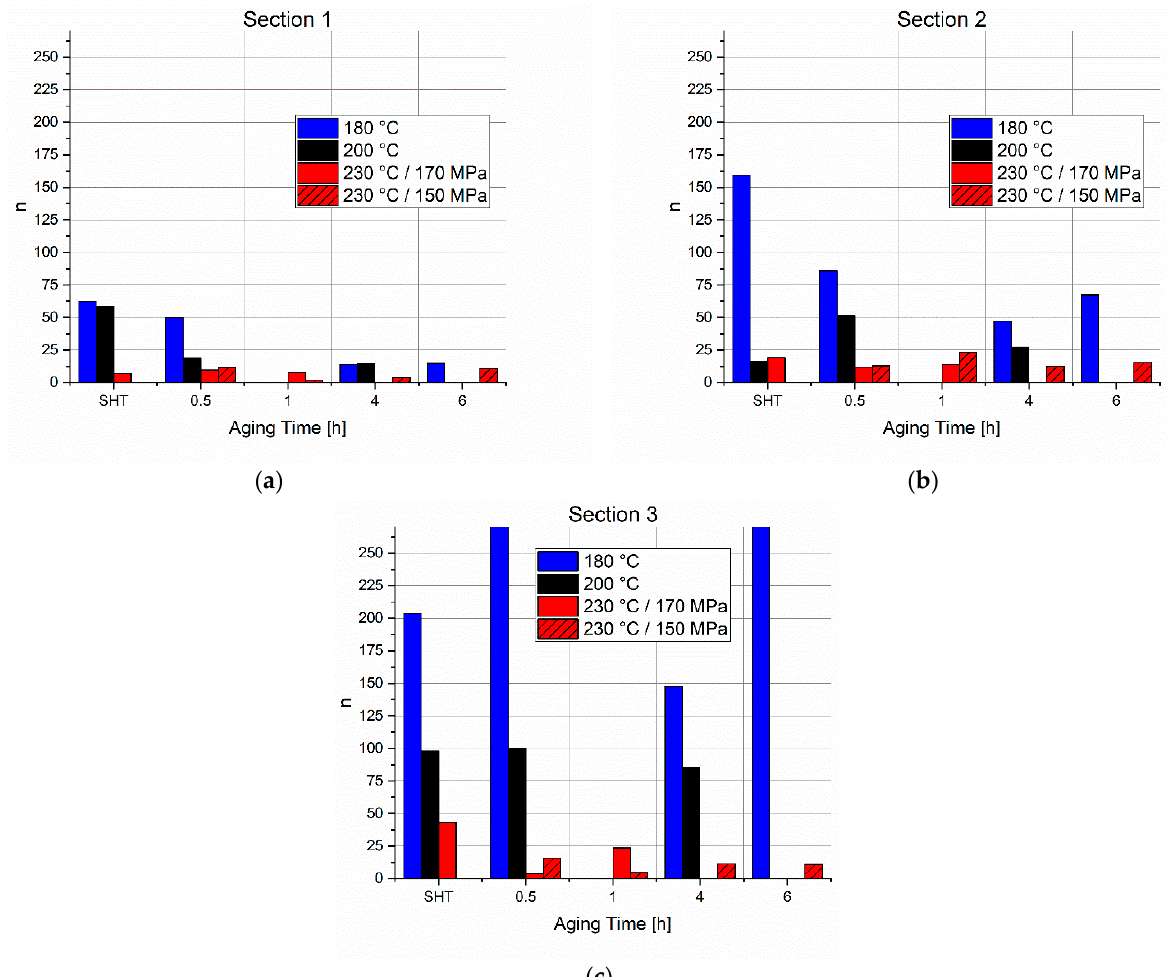
Figure 16. Calculated n values for ( a ) Section 1, ( b ) Section 2, and ( c ) Section 3.